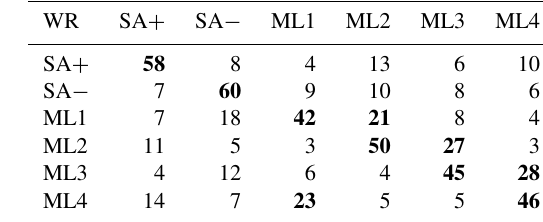
Table 3. WR transition rates in the ERA5 classification, computed as the percentage of transitions from a WR (rows) towards the others (columns). By definition, the diagonal represents persistence. Tran- sition rates above 1 / 6, i.e. the threshold for non-random transitions, are reported in